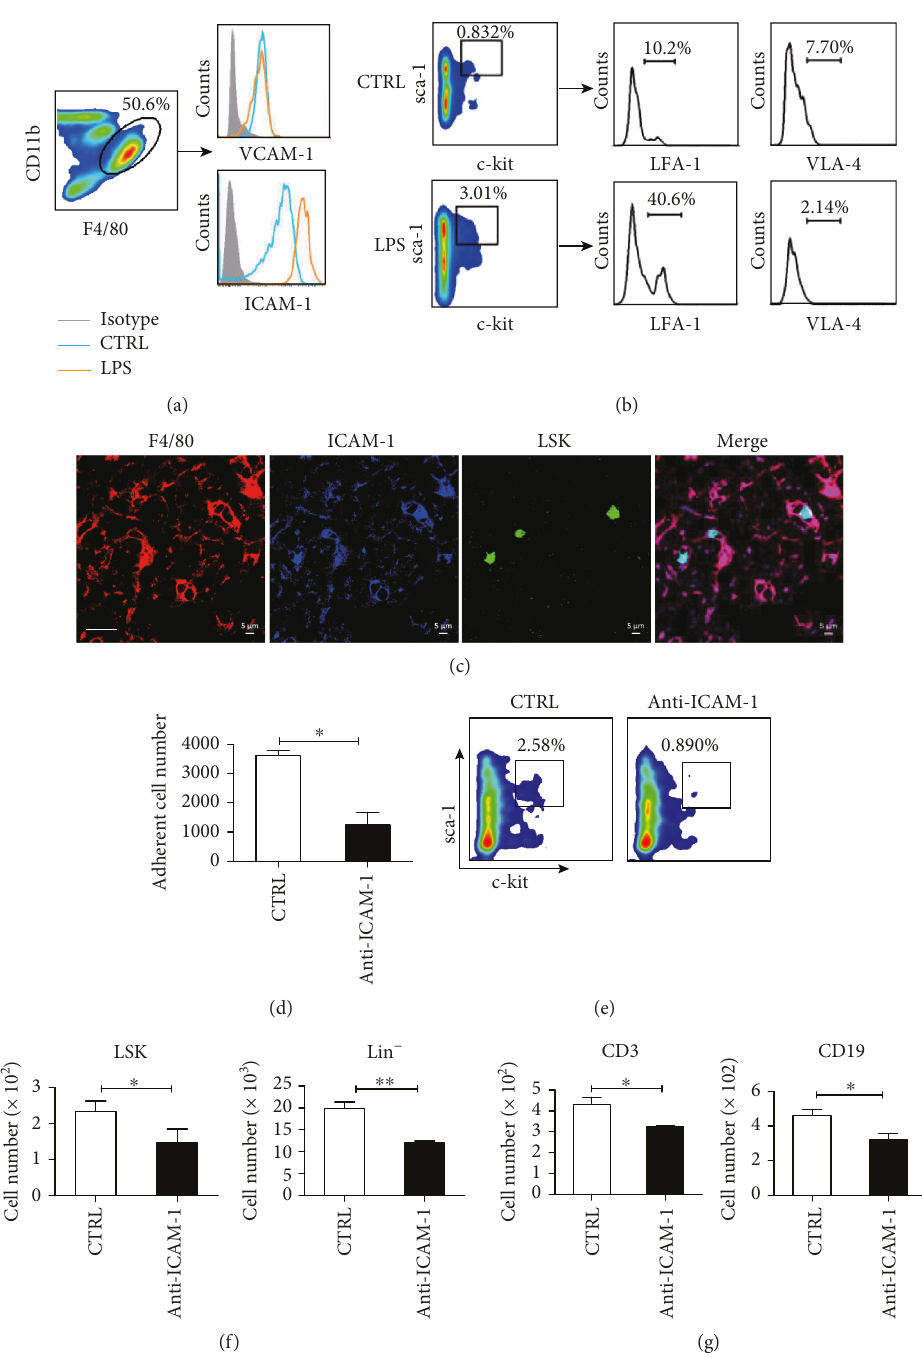
Figure 6: Kup ff er cells promote liver hematopoiesis via the interaction between ICAM-1 and LFA-1. (a) The expression of ICAM-1 and VCAM-1 on kup ff er cells from PBS- (blue) or LPS-treated mice (orange) was analyzed by fl ow cytometry. (b) Flow cytometry was used to measure the expression of LFA-1 and VLA-4 on liver LSK cells from PBS- or LPS-treated mice. (c) Immuno fl uorescence staining shows CFSE-labeled LSK cells (green) in close contact with ICAM-1 + (blue) kup ff er cells (F4/80 + , red) in the liver. Bar: 20 μ m. (d) Freshly isolated kup ff er cells were preincubated with anti-ICAM-1 (10 μ g/mL) and subsequently cocultured with sorted liver CFSE-labeled LSK cells in the presence of anti-ICAM-1 for 24h. Nonadherent CFSE + cells were counted by fl ow cytometry and compared with those from cocultures in the absence of anti-ICAM-1. (e) 3 75 × 10 5 Lin - cells isolated from the liver were cocultured with freshly isolated kup ff er cells in the presence of anti-ICAM-1 in vitro. The proportion of LSKs in the coculture system was detected by fl ow cytometry on day 7. (f) Statistical analysis of the absolute number of LSK cells and Lin - cells. (g) Freshly isolated LSK cells were cocultured with kup ff er cells in the presence of PBS or anti-ICAM-1. The cocultured cells were collected every seven days for analysis by fl ow cytometry. The statistical percentage of lymphocytes CD3 + T and CD19 + B cells in the LSK-kup ff er cell coculture system. Three replicate wells were established for each group. Data are represented as the mean ± SEM . ∗ P < 0 05 ; ∗∗ P < 0 01